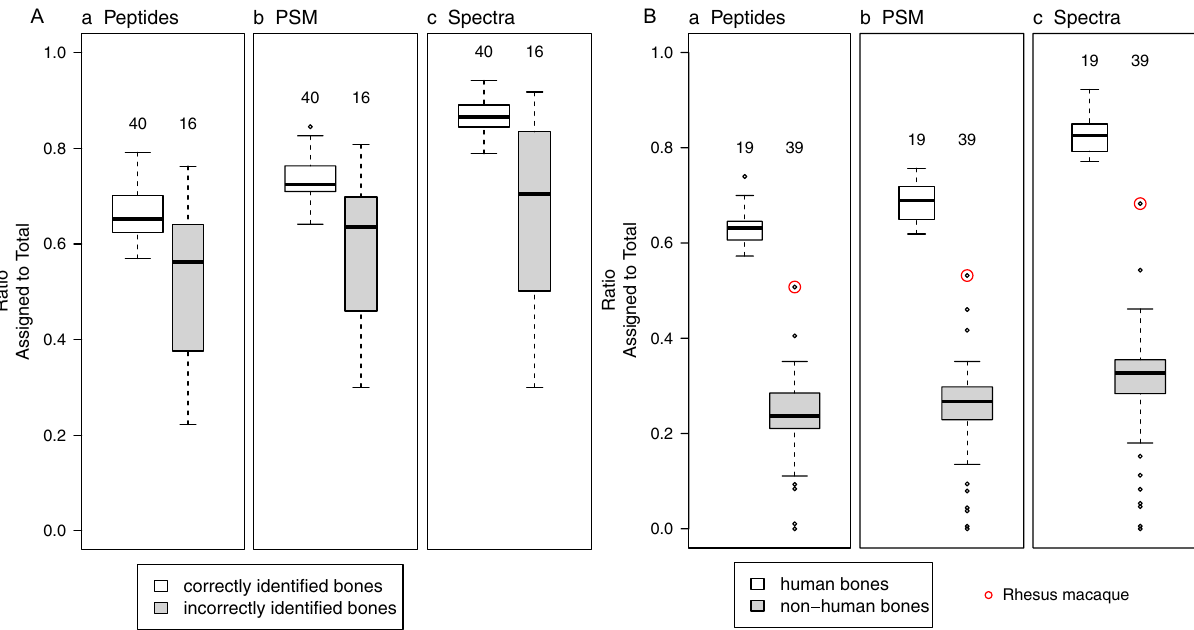
Figure 3. Comparison of peptide, PMS and spectra methods for determining species. ( A ) Comparison of distribution of ratios for correctly and incorrectly identified bone samples of known species, results from a mammal database search. (a) Non-redundant peptide/total peptides, (b) peptide-spectrum matches (PSM)—i.e. all (redundant) peptide identifications/total peptides, (c) all (redundant) spectra/total spectra. On average 77% of spectra were found two or more times with a mean of ~ 5.7 spectra for each sequence (median 3, range 6–55). As results are from a mammal database search, incorrectly identified samples include all seven non-mammal samples. Above each box plot is the total number of samples in each category. ( B ) Comparison of distribution of ratios (peptides or spectra assigned to human/total peptides or total spectra identified) for human and non- human bone samples using results from vertebrate database search. Descriptions of a–c same as ( A ). Rhesus macaque, the only non-human primate, is circled in